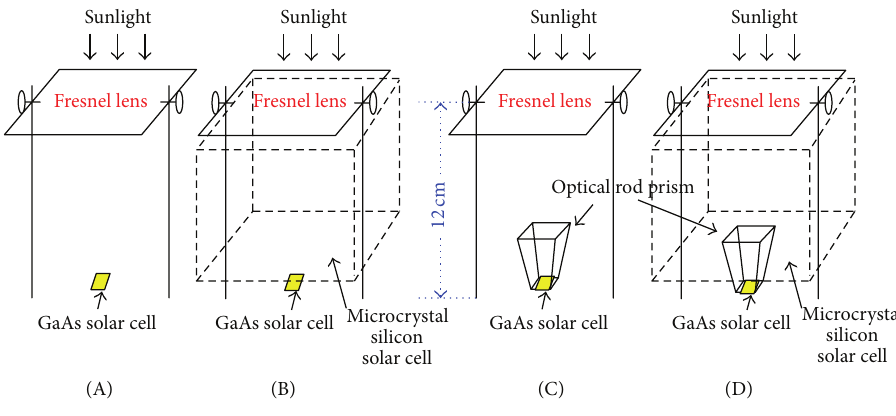
Figure 1: Four different mechanisms are used in this research work.